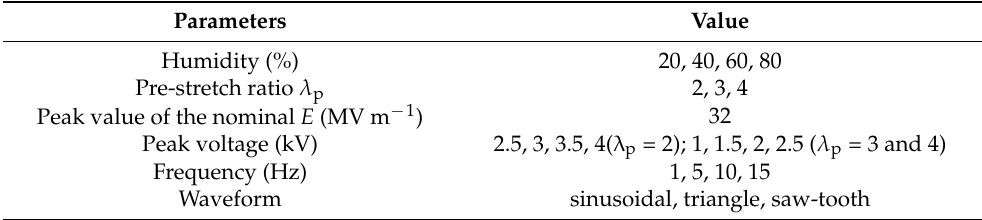
Table 1. Humidities, pre-stretch ratios, initial nominal electric strengths, peak voltages, frequencies and waveforms for electromechanical